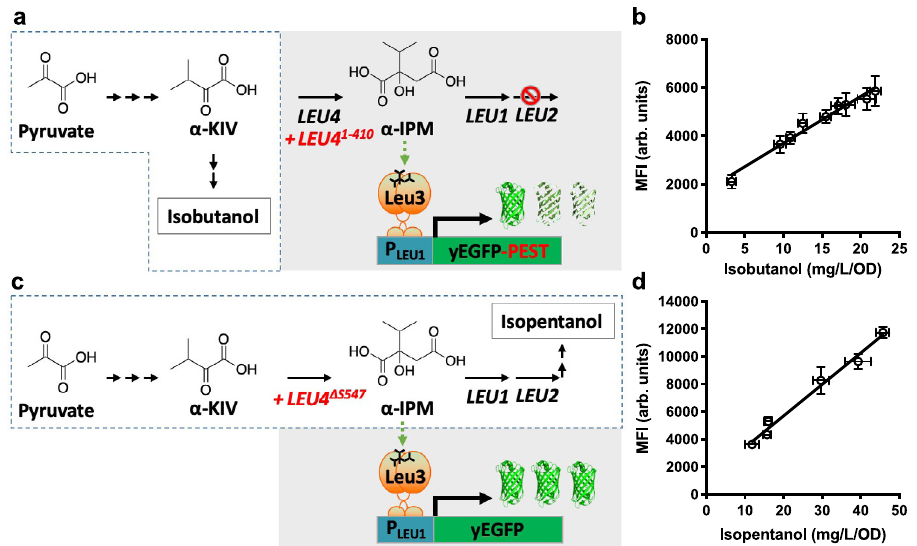
Fig. 1 Design and characterization of two BCHA biosensor con fi gurations. a Schematics of the biosensor in the isobutanol con fi guration (gray box) and simpli fi ed isobutanol pathway (enclosed by dashed lines; each arrow represents one enzymatic step). The α -isopropylmalate ( α -IPM), which activates Leu3p (green dashed arrow), is an isobutanol by-product that accumulates due to deletion of LEU2 . Thus, adding a PEST tag to destabilize yEGFP reduces background. α -KIV, α -ketoisovalerate. b Correlation between speci fi c isobutanol titers (mg/L/OD) produced by engineered strains and GFP median fl uorescence intensity (MFI) from the isobutanol biosensor. Strains used (from left to right): YZy121, YZy230, YZy81, YZy231, YZy232, YZy233, YZy234, YZy235, and YZy236 (Supplementary Table 1). c Schematics of the biosensor in the isopentanol con fi guration (gray box) and simpli fi ed isopentanol pathway (enclosed by dashed lines; each arrow represents one enzymatic step). In this case, α -IPM is an isopentanol precursor that does not accumulate due to LEU2 activity, so the PEST tag on yEGFP is not required. d Correlation between speci fi c isopentanol titers (mg/L/OD) produced by engineered strains and GFP median fl uorescence intensity (MFI) from the isopentanol biosensor. Strains used (from left to right): SHy187, SHy188, SHy192, SHy159, SHy176, and SHy158 (Supplementary Table 1). The MFI for each strain was measured 13 h after inoculation, during the exponential phase, and plotted against the corresponding speci fi c isobutanol or isopentanol titers obtained after 48-h high-cell-density fermentations. MFI are represented in arbitrary units (arb. units). All data are shown as mean values. Error bars represent the standard deviation of at least three biological replicates. Source data are provided as a Source Data fi